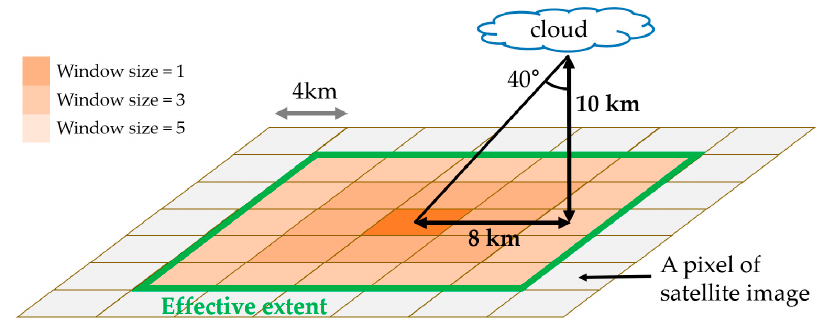
Figure 4. Illustration of the effective extent.